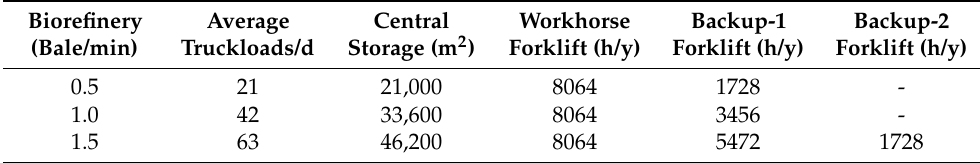
Table 5. Logistics system specifications for different capacity